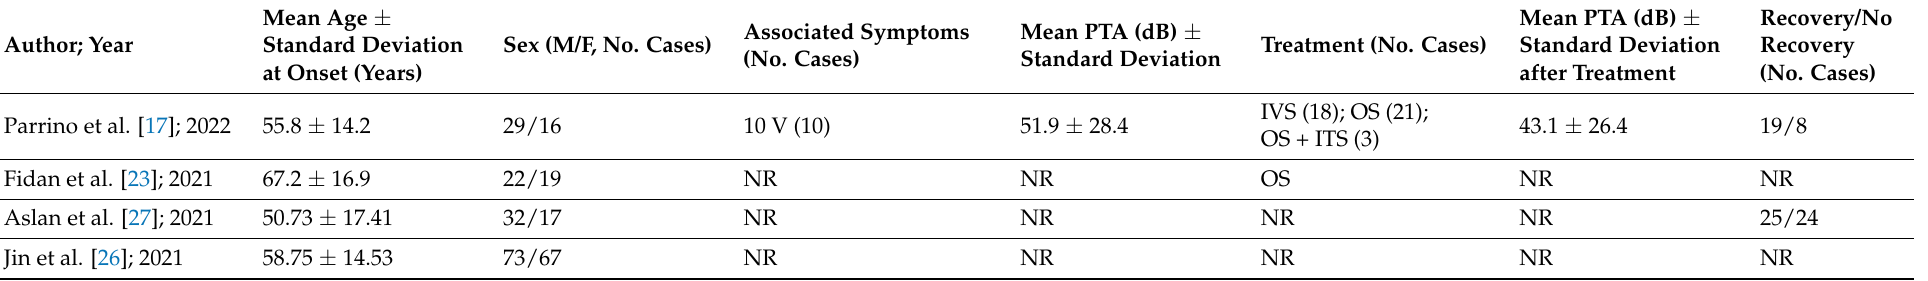
Table 3. SSNHL patient’s demographic information, PTA, and administered treatment for studies that considered controls in